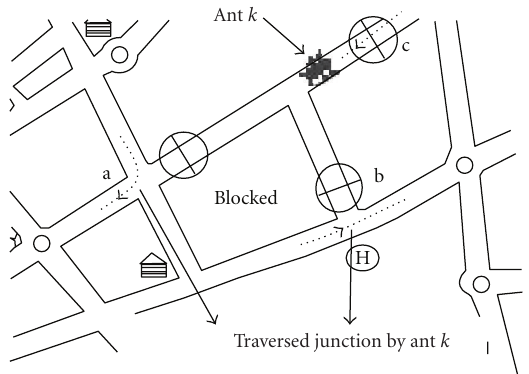
Figure 5: An ant on a blocked junction. The junctions “a” and “b” have been traversed by ant k before. Therefore, it cannot pass these junctions once more and is blocked in the current junction “c” in the current iteration.